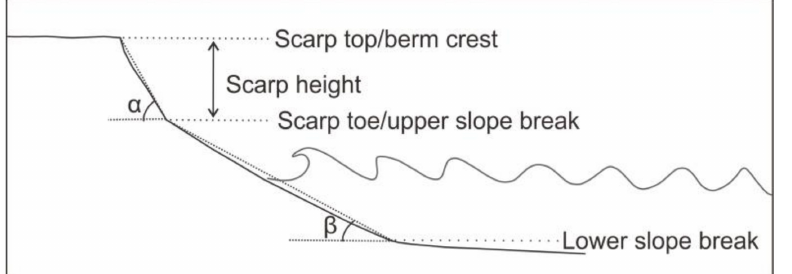
Figure 3. Definition sketch for beach scarps and associated slopes. α and β are the upper and middle beach slope,